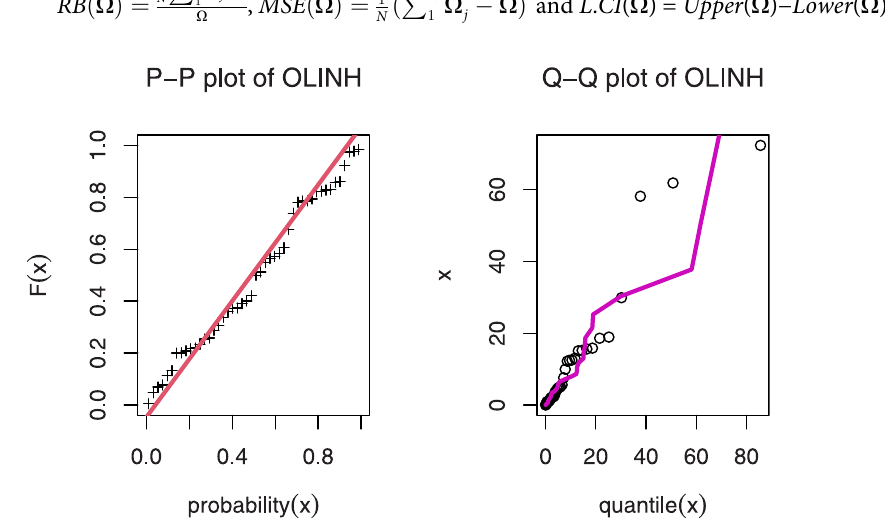
Fig 6. P-P and Q-Q plot of the OLINH distribution for COVID-19 vaccination data.